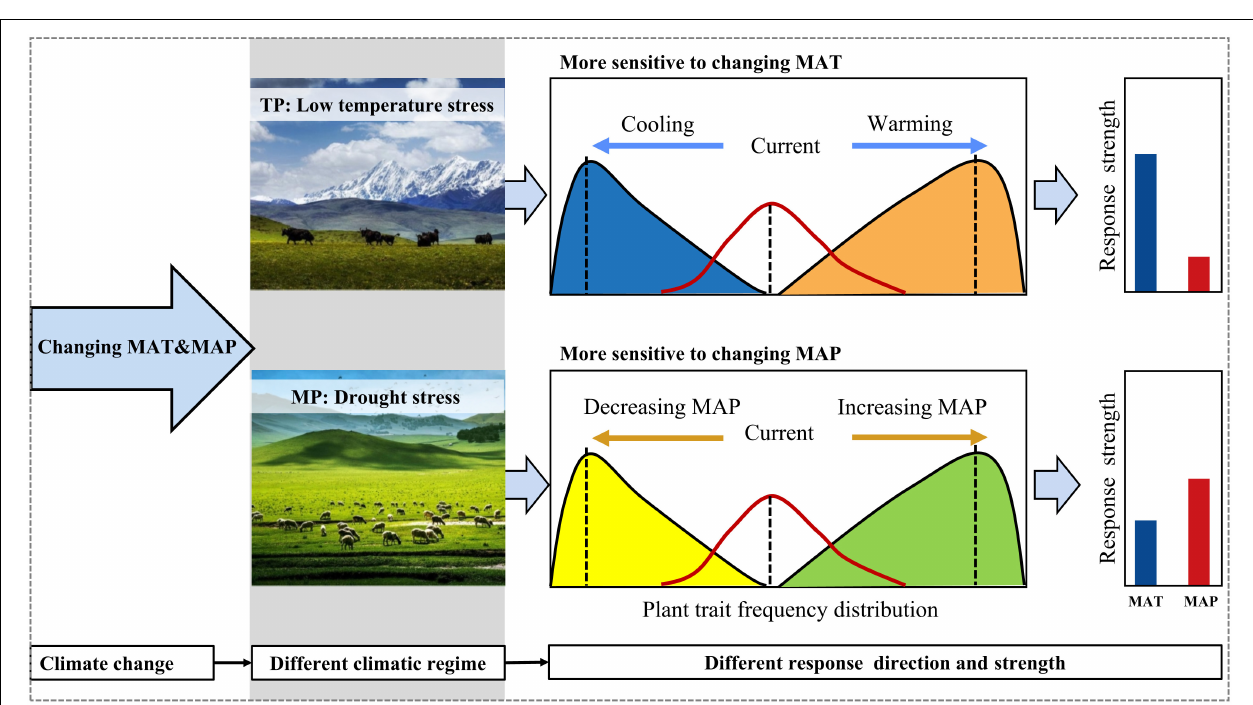
FIGURE 6 | A theoretical framework for the different responses of community assembly to climate change. The specifics of the climatic regimes will govern the direction and strength of the responses to changes in climate. MAP, mean annual precipitation; MAT, mean annual